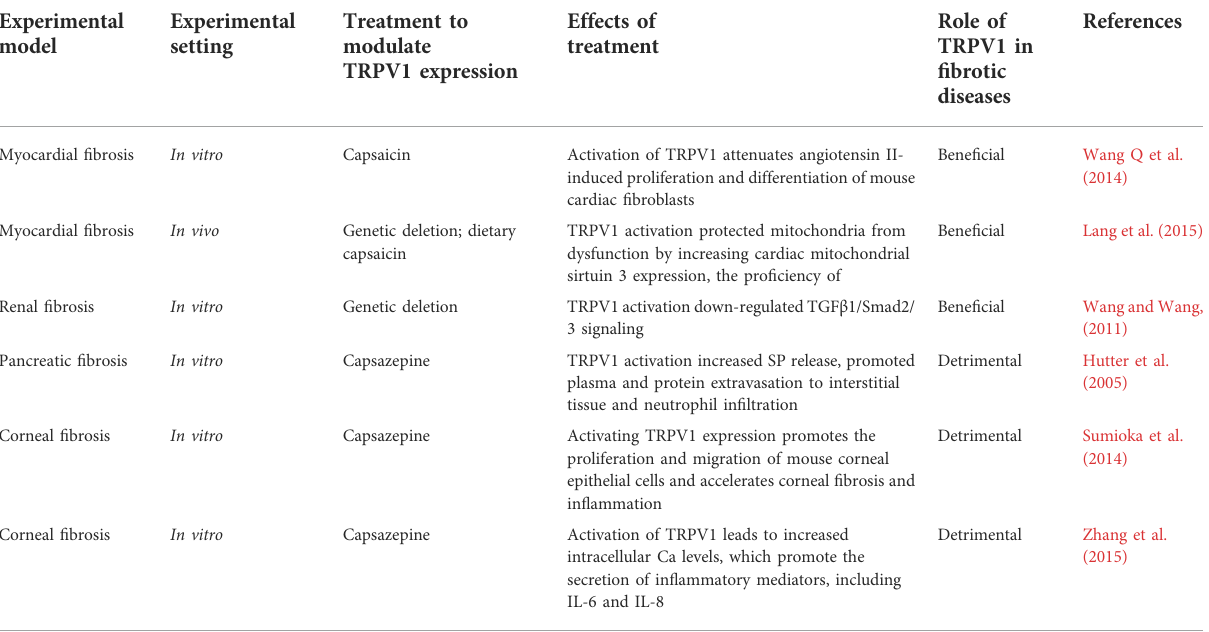
TABLE 1 Summary of the role played by TRPV1 in fi brotic disease. Experimental